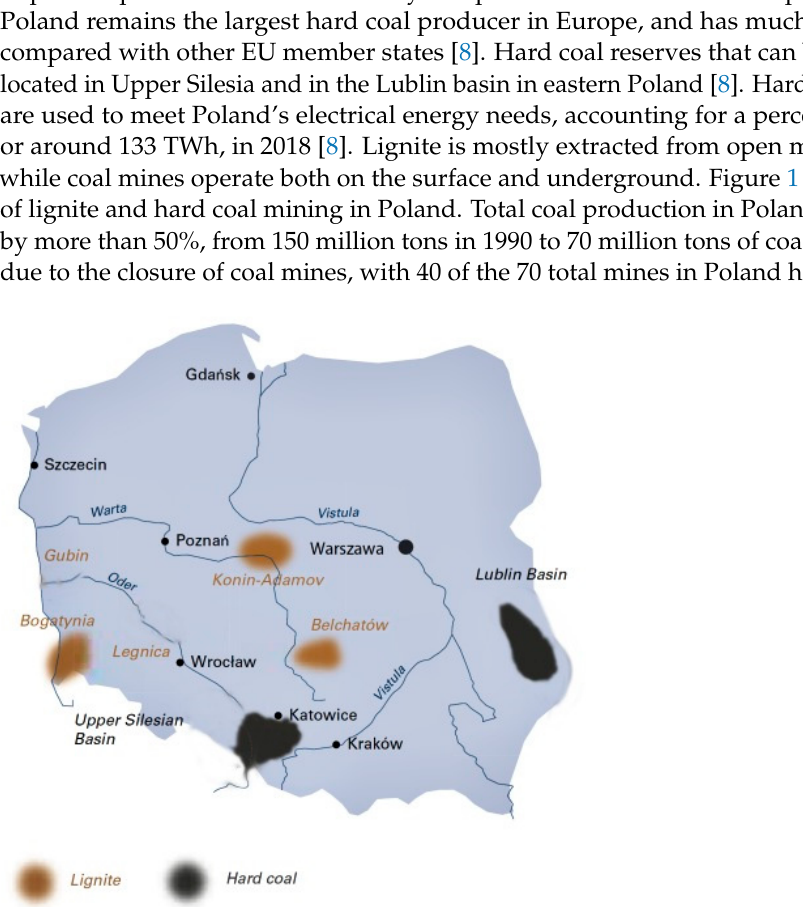
Figure 1. Location of main hard coal and lignite mining areas in Poland. Poland has four rock salt deposits that are actively managed and utilized, two of them as underground salt mines (Sieroszowice/Kazimierz ó w and Kłodawa) and the other two as a storage for gas and oil (G ó ra and Mogilno)